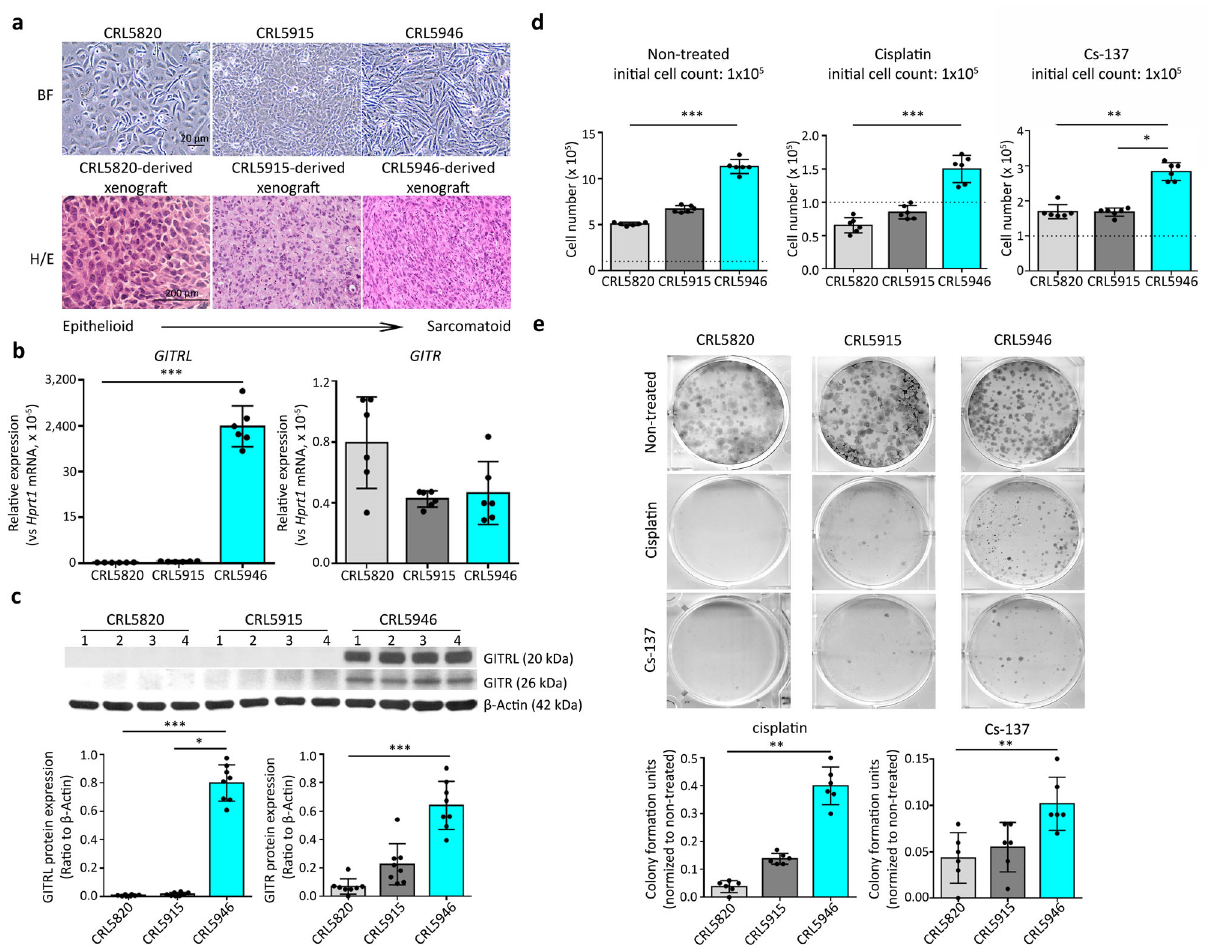
Fig. 1 Characteristics of three human mesothelioma cell lines. a Top panel: Representative image of phase contrast microscopy shows the difference of cell morphology among the three cell lines. Bottom panel: A total of 6 × 10 6 of CRL5820, CRL5915, or CRL5946 cells were subcutaneously or intraperitoneally injected into NOD/SCID mice. Representative images of H&E staining of xenografted tumor from mice in each treatment group. b , c Comparison of GITRL and GITR expression among mesothelioma cell lines by using qPCR ( b ) and immunoblot analysis ( c ) ( n = 8). d Mesothelioma cell lines were treated with 2 μ g/mL cisplatin or exposed to 7.5 Gy Cs-137 irradiation and the cell proliferation was analyzed by counting the number of viable cells 4 days after treatment ( n = 6). e Representative image of colony formation assay and quanti fi cation of visualized colonies in cells 14 days after exposure to 2 μ g/mL cisplatin or Cs-137 7.5 Gy irradiation ( n = 6). Data were analyzed with non-parametric Kruskal – Wallis test followed by